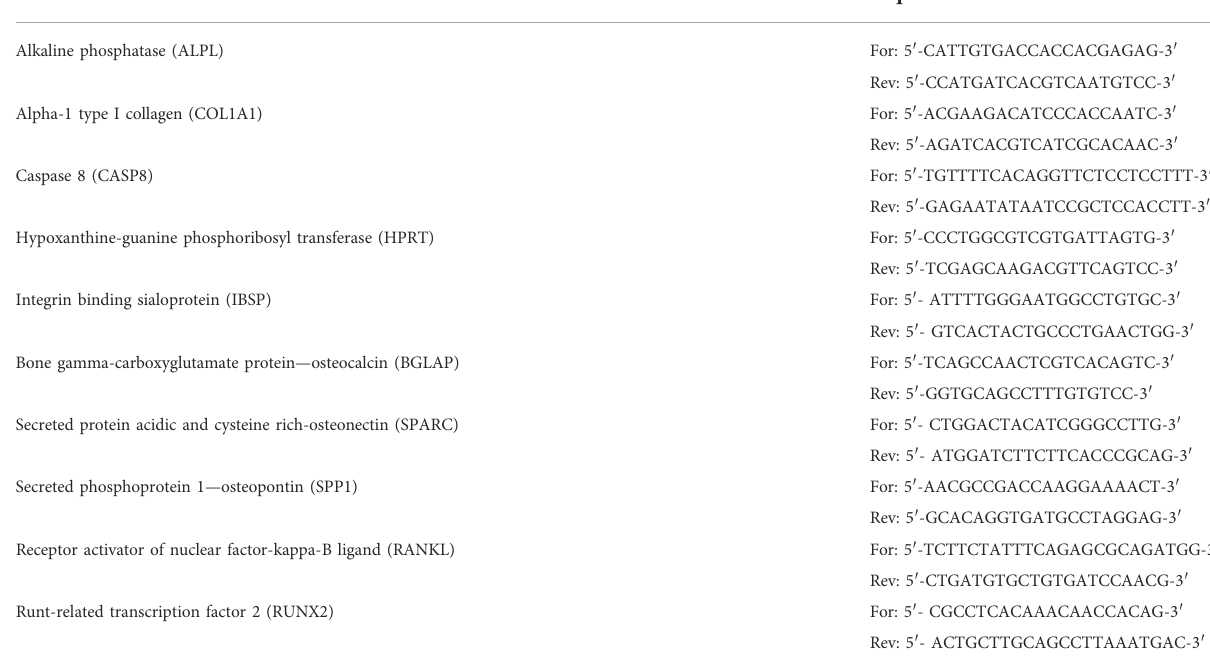
TABLE 1 Primer sequences for the genes of interest. Gene